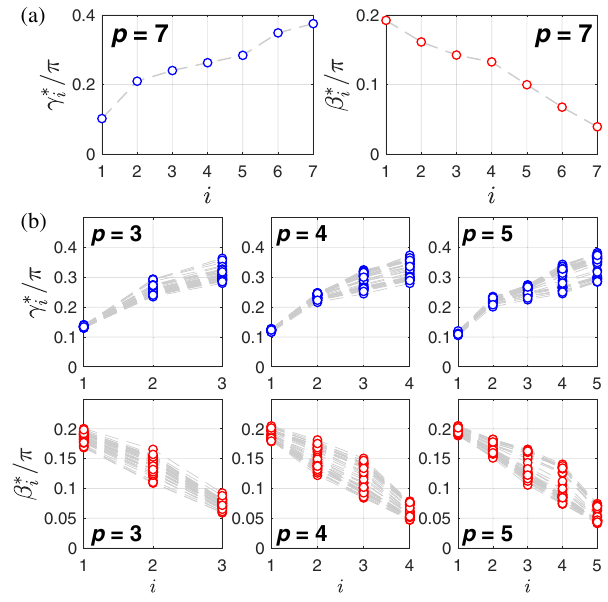
⃗ β (cid:3) FIG. 2. (a) Optimal QAOA parameters ð ⃗ γ (cid:3) ; Þ for an example instance of MaxCut on a 16-vertex unweighted 3-regular (u3R) graph at level p ¼ 7 . (b) The parameter pattern visualized by plotting the optimal parameters of 40 instances of 16-vertex u3R graphs, for 3 ≤ p ≤ 5 . Each dashed line connects parameters for one particular graph instance. For each instance and each p , we use the classical BFGS optimization routine [35] from 10 4 random initial points, and keep the best